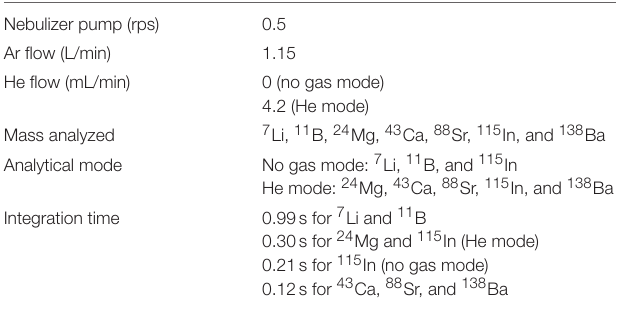
TABLE 2 | Summary of the ICP-MS operating